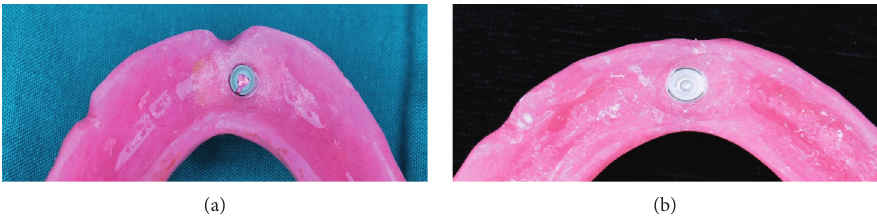
Figure 4: (a) PEKK matrix after pickup. (b) Nylon matrix after